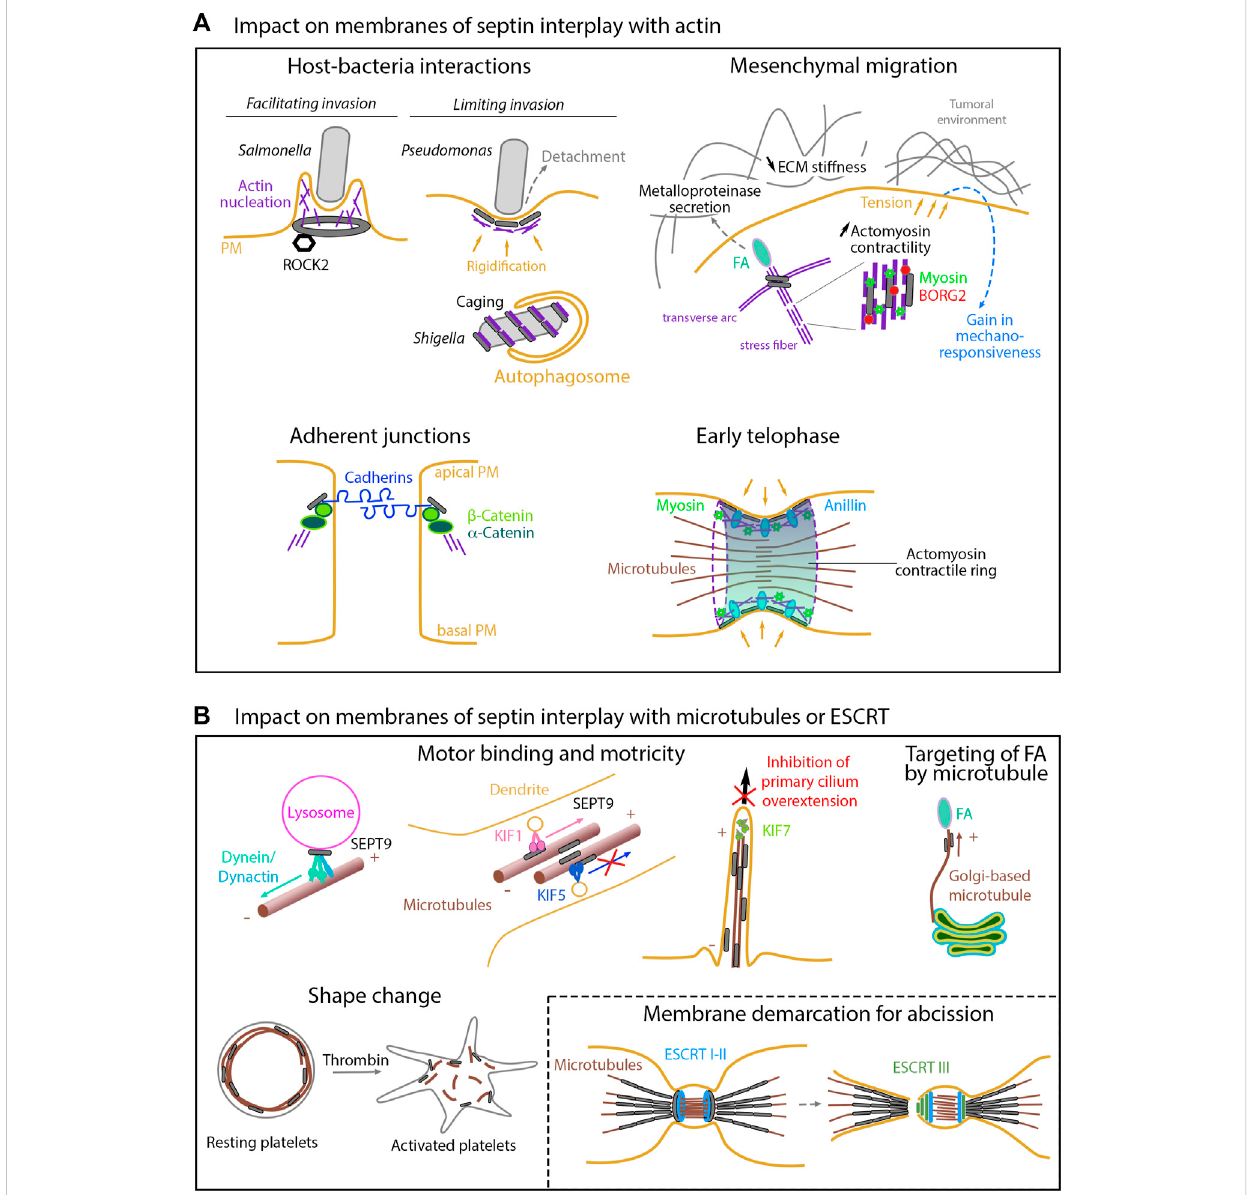
FIGURE 2 Impact on membranes of septin interplay with other cytoskeletons (A) Actin-related impacts. While facilitating cell invasion of speci fi c bacteria, septinscanalsolimitinvasioneitherbyenhancinghostcellrigidityorbyfavoringautophagy-mediateddegradationoncebacteriahavebeeninternalized. During mesenchymal migration, septins contribute to the stabilization of nascent focal adhesions and to extracellular matrix degradation through metalloproteinase secretion. Septin-mediated enhancement of actomyosin contractility ultimately increase cell tension forces, thereby impacting the tumoral environment and modulating mechano-responsiveness. By linking the catenin complex to the actin cytoskeleton, septins favor cell-cell junctions required for the apico- basal polarity. During cytokinesis, membrane-associated septins and anillin are required to anchor the actomyosin contractile ring to the cell cortex. (B) Microtubule- and ESCRT-related impacts. Septins control the binding and motricity of molecular motors, thereby regulating the retrograde and anterograde transport on microtubules of proteins or vesicles, as illustrated with the clustering of lysosomes during cell adaptationtostress,thesortingofkinesinmotorcargoesduringentryintodendrites,orthecontrolofciliaover-elongation.Byguidingnon-centrosomal Golgi-basedmicrotubules,septinsarealsoinvolvedinfocaladhesiondisassemblyinmigrating cells.Delocalizationofseptinsfrommicrotubulesimpacts cellshape,asillustratedinplatelets.Duringcytokinesis,membrane-boundseptinringsdemarcatethemembranesitesforESCRTIIIringassemblypriorto fi nal abscission.